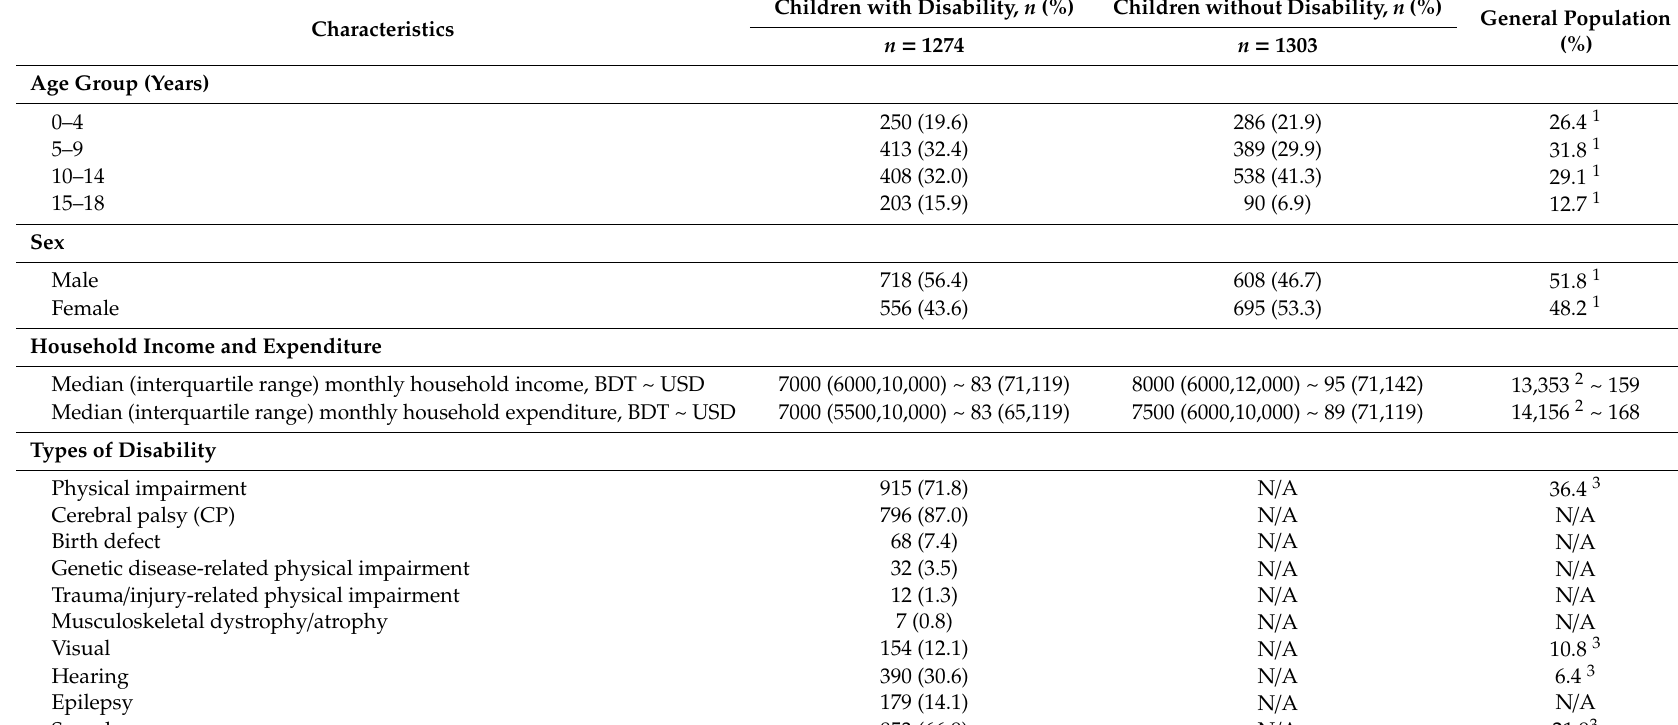
Table 1. Characteristics of the study